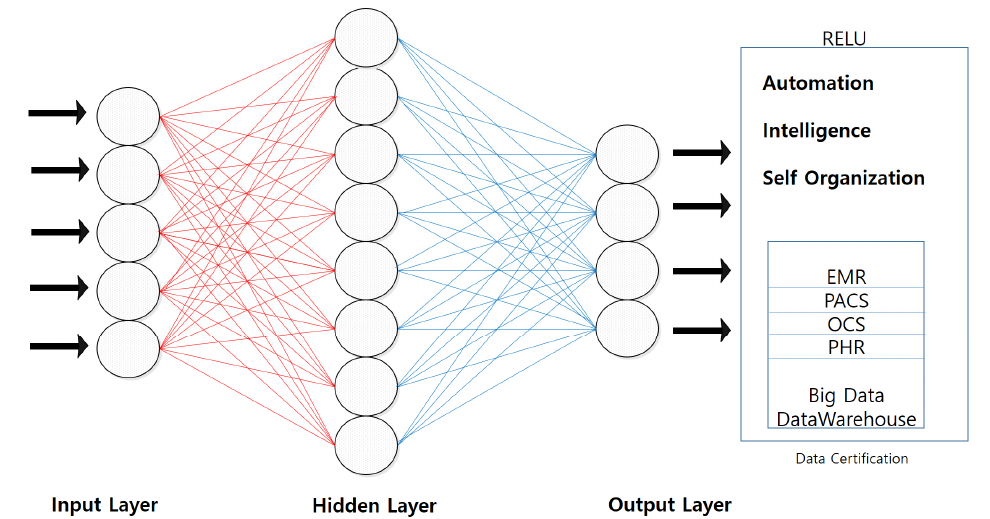
Figure 2. Concept of an artificial intelligence neural network for healthcare.